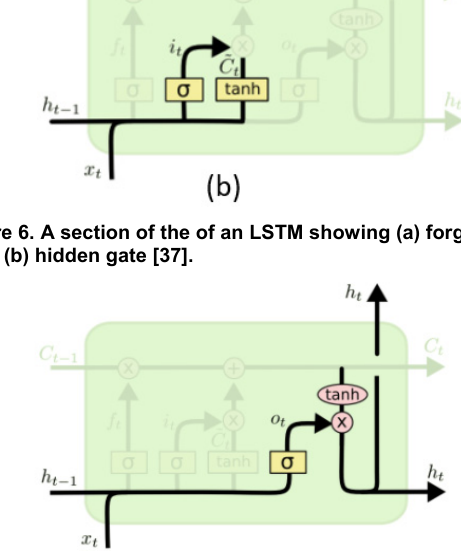
Figure 7. A section of the of an LSTM showing how the combination of the sigmoid and tanh output